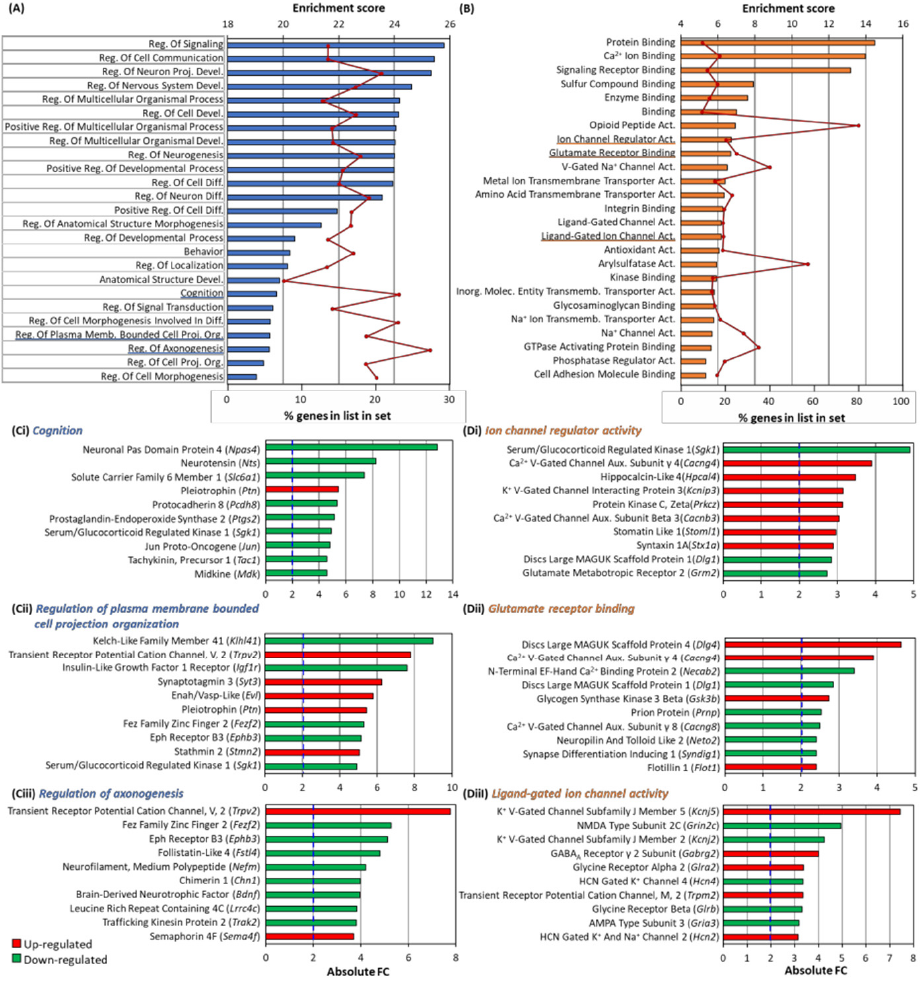
Figure 8. GO analysis of Arc knock-down. ( A , B ) Gene set enrichment analysis was performed to investigate the biological processes ( A ) and molecular functions ( B ) that the altered genes were involved in. The enrichment score is plotted against the category names. The enrichment score is the negative natural logarithm of the enrichment p -value derived from Fisher’s exact test and reflects the degree to which the gen e sets are overrepresented at the top or bottom of the entire ranked list of genes. Bars indicate the enrichment score while the line graph indicates the percentage of genes that are altered under the respective GO term. The top 25 biological processes ( A ) and molecular functions ( B ) are shown. Many of the categories are related to synaptic plasticity (underlined blue and orange) [20,21]. ( C , D ) Bar-charts showing genes involved in the stated category from Biological Processes ( Ci – Ciii ) and Molecular Functions ( Di – Diii ) and their respective fold changes. The top 10 regulated genes are shown. Dotted blue line indicates an absolute Fold Change of 2.